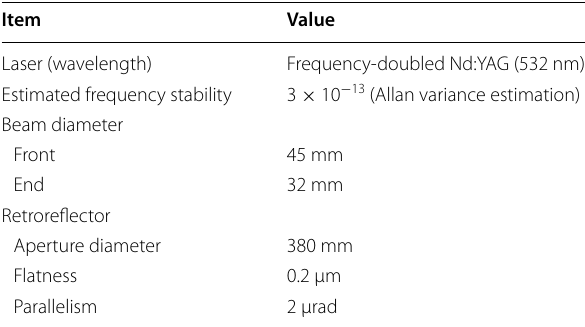
Table 2 Optical parameters for the 1500-m laser strainme-